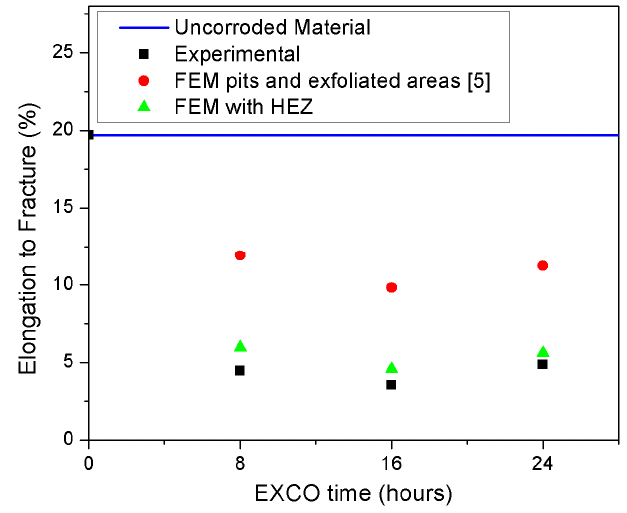
Figure 12. Experimental and numerical reductions in elongation to fracture with corrosion exposure